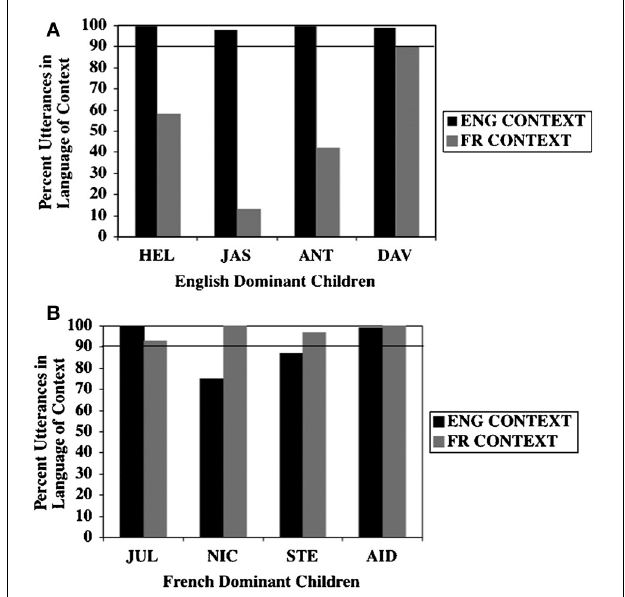
FIGURE 2 | Unimodal bilinguals. Percent use of utterances in the language of the context by (A) English-dominant children and (B) French-dominant children in English and French contexts (Paradis and Nicoladis, 2007) (Reproduced with permission from Taylor and Francis).